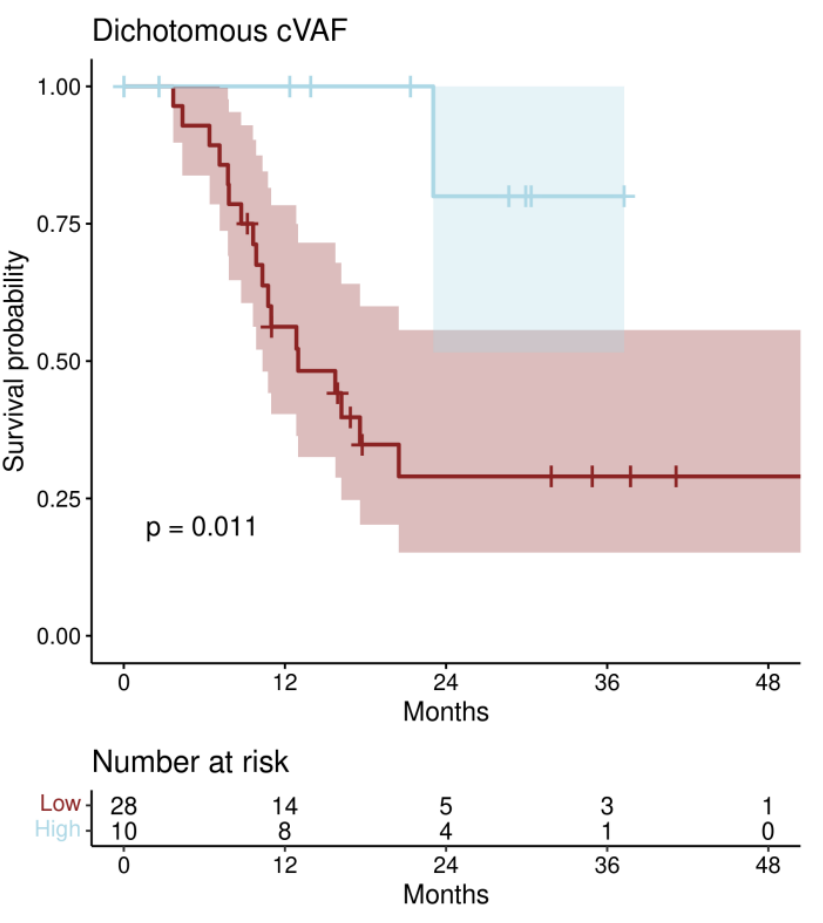
Figure 4. Kaplan–Meier estimates for PFS categorizing cVAF optimally in a low and high cVAF group. Figure 4. Kaplan – Meier estimates for PFS categorizing cVAF optimally in a low and high cVAF Shading areas are 95% confidence intervals. group. Shading areas are 95% confidence intervals. Table 3. Univariate and multiple Cox-Regression for progression-free survival.